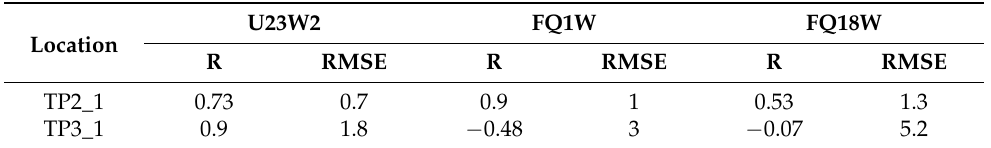
Table 12. Correlation of InSAR measurements from the SBAS analysis and field water level measure- ments using different datasets from Radarsat-2 in Long Point in 2018. U23W2 FQ1W FQ18W Location R RMSE R RMSE R RMSE TP2_1